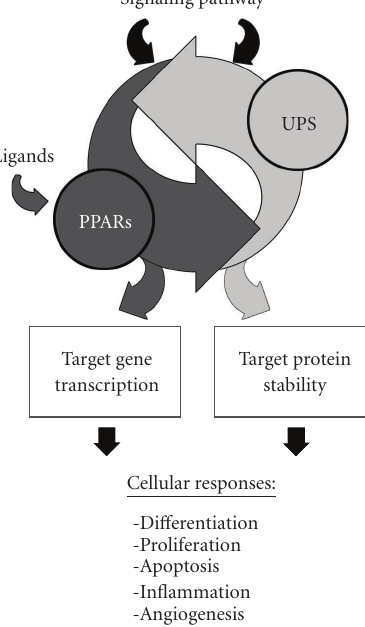
Figure 3: Interactions between PPARs and the ubiquitin-proteasome system (UPS) a ff ect multiple cellular pathways . The UPS regulates activity of PPARs by controlling receptor turnover in ligand dependent and independent manners and a ff ecting the ability of PPARs to regulate target gene transcription. Signaling pathways can modulate PPAR activity by a ff ecting UPS-mediated turnover (e.g., increased PPAR γ degradation in response to growth factors or hormones). PPAR can also a ff ect biological pathways and cellular responses by increasing or decreasing susceptibility of proteins to proteasomal degradation (e.g., enhanced degradation of β -catenin and suppression of the Wnt pathway by PPAR γ